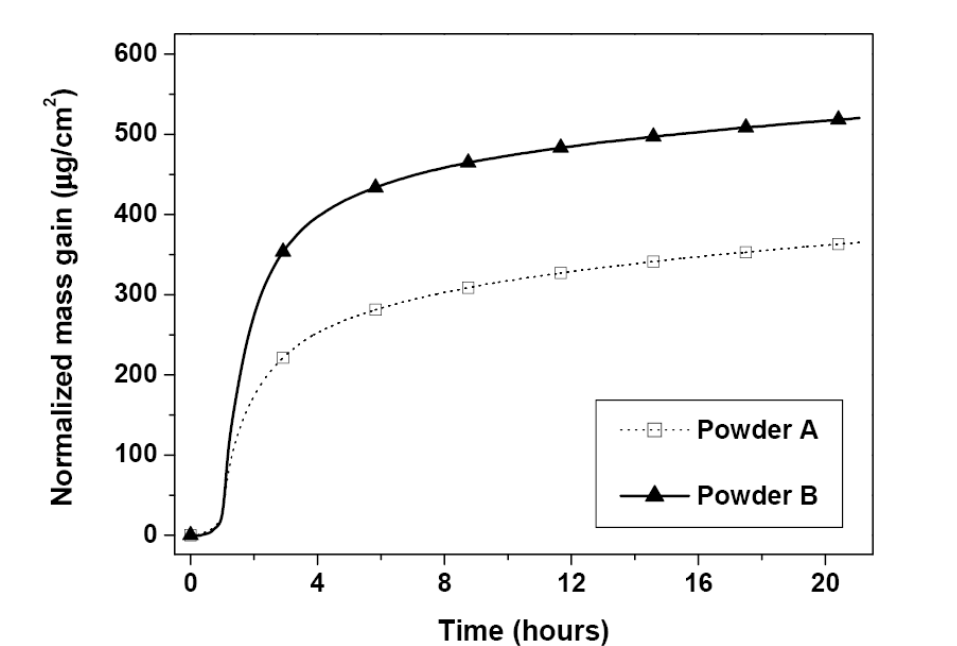
Figure 3. Comparison between TGA curves (at 1,273 K) of powders A and